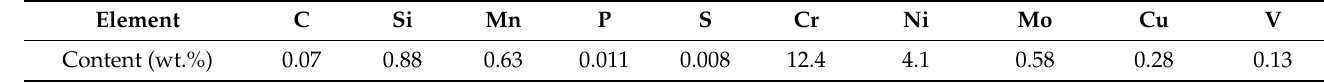
Table 1. Chemical composition of